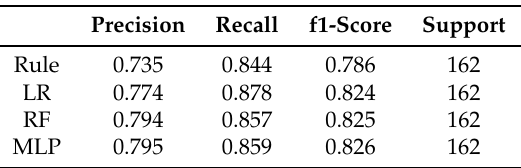
Table 2. Comparison of different prediction methodologies (Rule-based approach, Logistic Regression, Random Forest, Multilayer Perceptron) on the same set (test set).